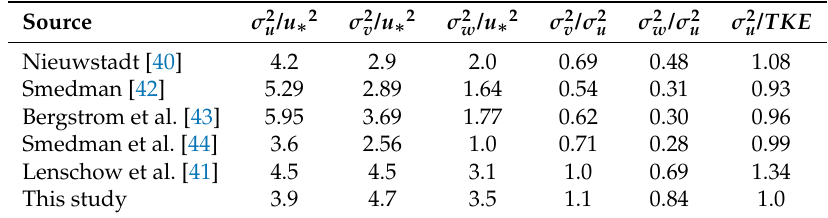
Table 2. Relations between different turbulent quantities, as reported in